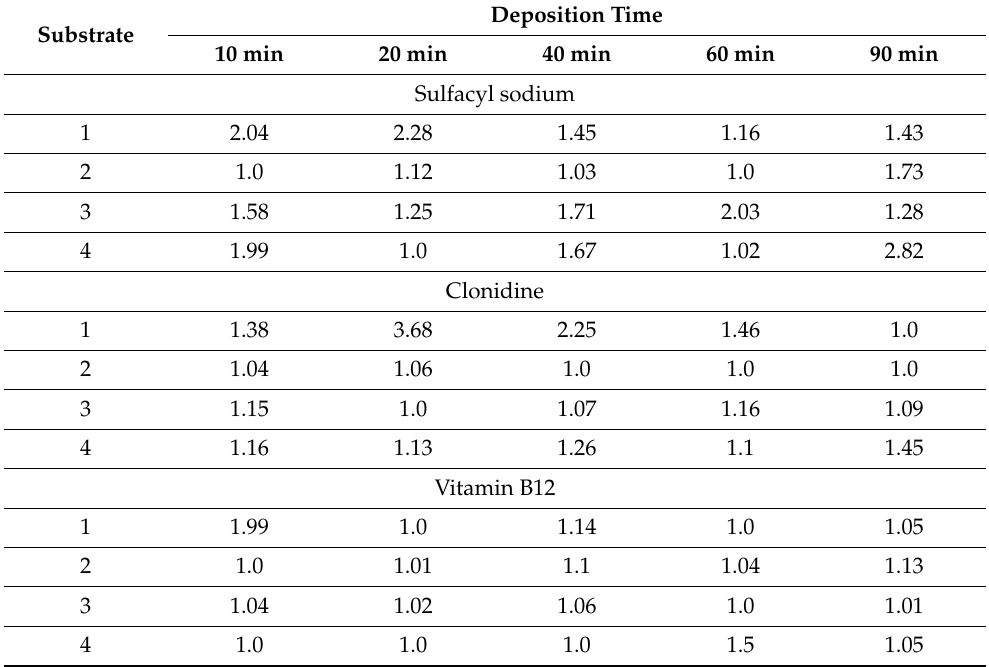
Table 3. Light-to-dark ratio of organic–carbon hybrids with different organics on various substrates.